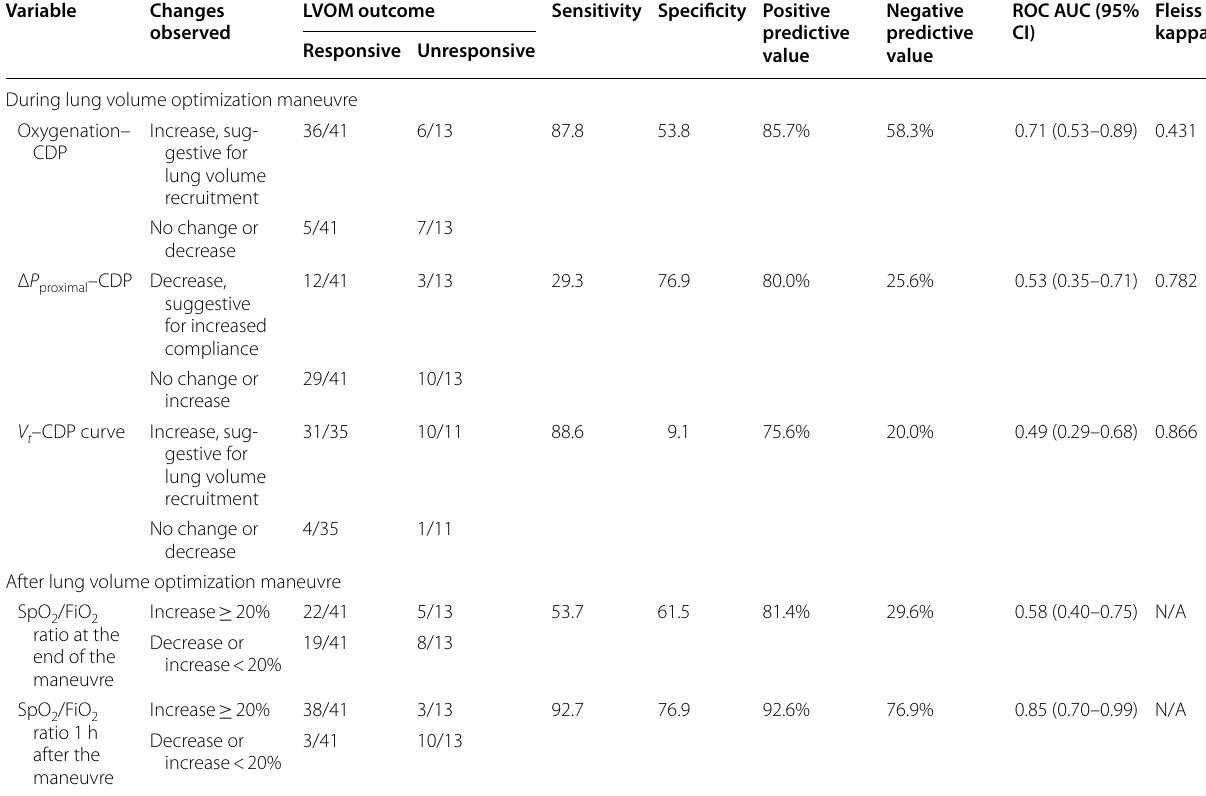
Table 2 Classification results from plots of metrics for oxygenation, proximal pressure amplitude (Δ P volume ( V ) plotted against the continuous distending pressure (CDP) with corresponding sensitivity, specificity, positive t and negative predictive value calculated using the respiratory inductance plethysmography–CDP plots as